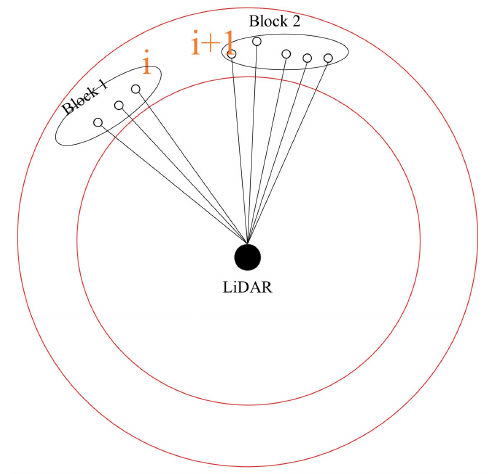
Figure 4. Clustering of laser points. The angle difference between points i and i +1 in the same region is greater than the θ threshold , and they are divided into different